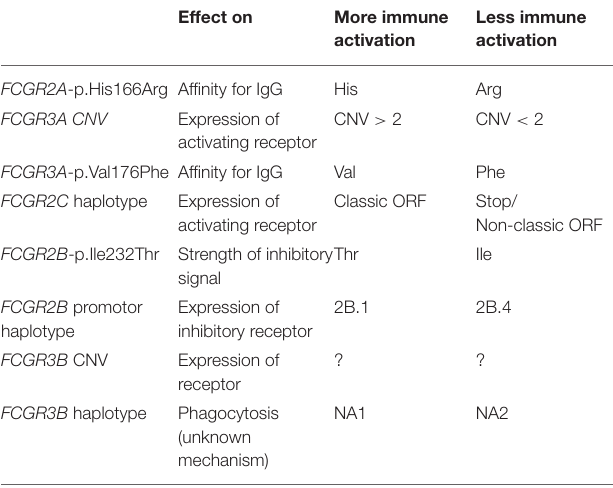
TABLE 2 | Effects of genetic variants at the FCGR2/3 locus on immune function. Effect